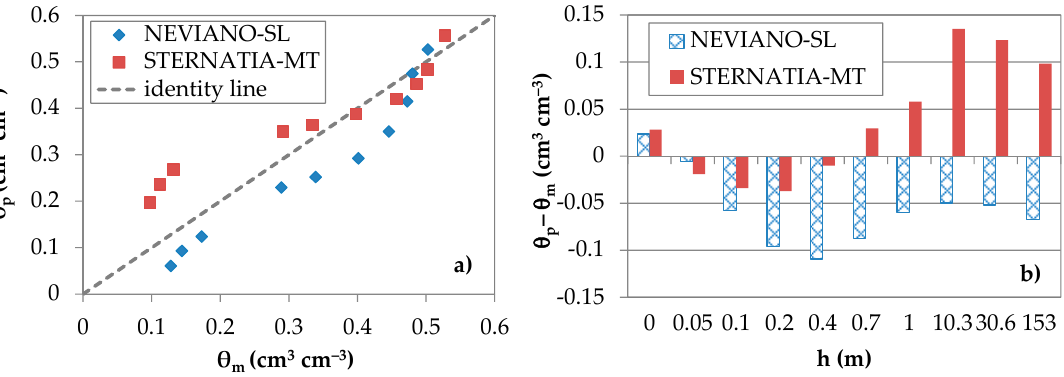
Figure 4. Comparison between predicted ( θ p ) and measured ( θ m ) soil water retention at Neviano and Sternatia sites ( a ) and corresponding differences as a function of soil pressure head ( h ) values ( b ).